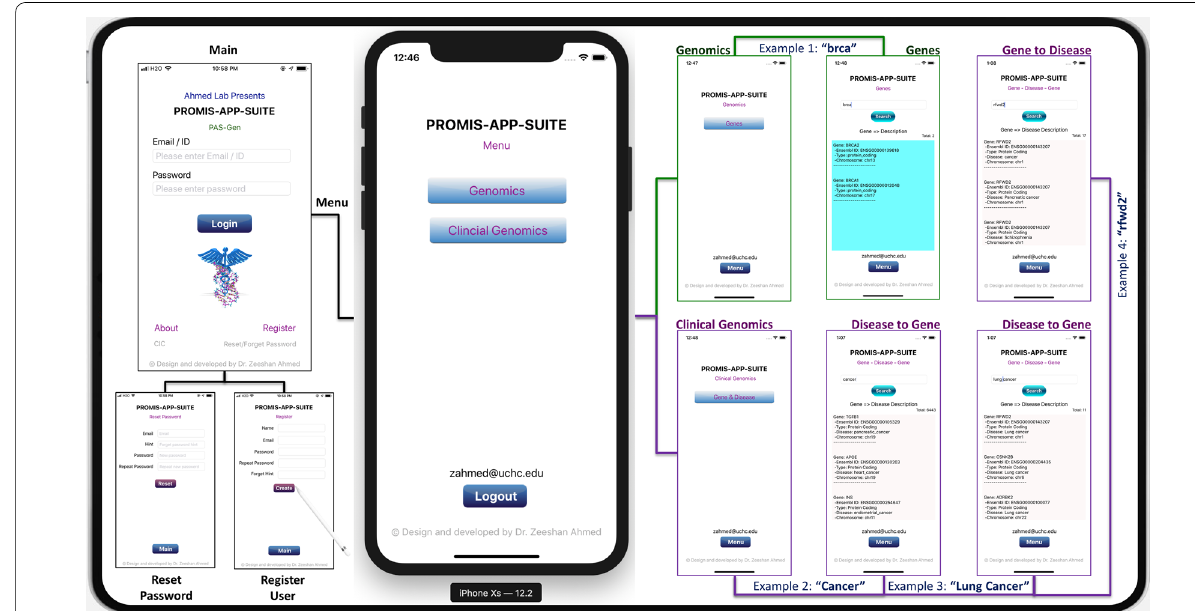
Fig. 1 PAS-Gen navigating graphical user interfaces with examples of searched Gene, Gene to Disease, and Disease to Gene results. PAS-Gen (iPhone XS and 8) screen display includes About, Register User, Reset Password, Main, Menu, Genomics, Clinical Genomics, Genes, and Genes and Disease interfaces. Example 1 shows a search by entering an incomplete gene name “BRCA” (BReast CAncer gene) that reveals the for protein coding genes “BRCA1” and “BRCA2” and related details. Example 2 is a search using keyword “cancer” that presents 6443 genes known to be involved in different kinds of cancers. In example 3, a search for a specific disease “lung cancer” resulted in a total of 11 genes and related diseases. Example 4 demonstrates a search for the gene “RFWD2”, and results revealed 17 disease matches including a protein coding gene with Ensembl ID “ENSG00000143207” at Chromosome 1 associated with the disease “Autism”. Detailed results are attached in Additional file